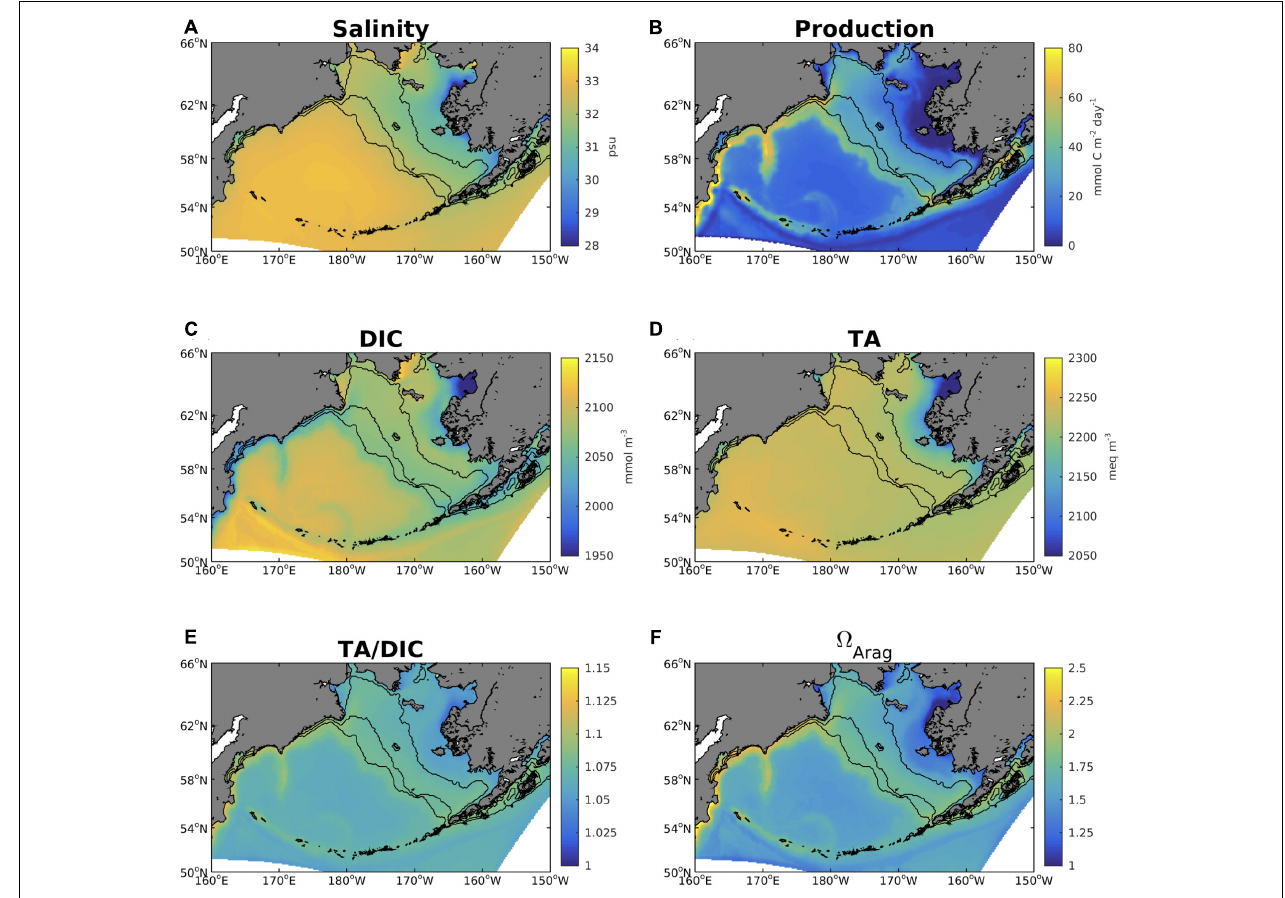
FIGURE 8 | Annual average plots of model (A) surface salinity, (B) primary production integrated over the top 200 m of the water column, (C) surface DIC, (D) surface TA, (E) surface TA/DIC ratio, and (F) surface (cid:127) Arag . All variables are averaged over the 2003–2012